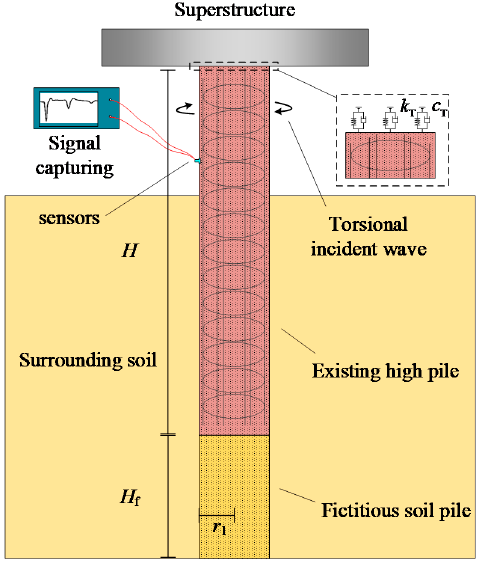
Figure 1. Schematics of torsional low-strain test for existing high-pile foundations.